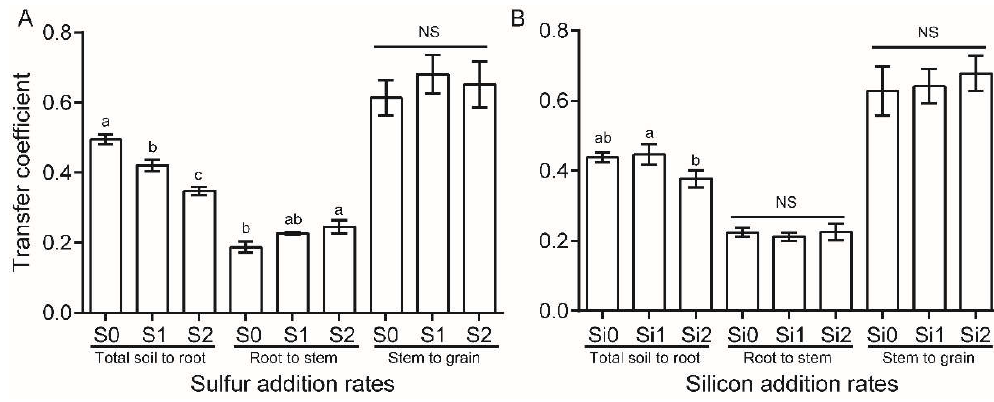
Figure 3. Transfer coefficient of Cu in the soil-root-stem-grain system in response to ( A ) sulfur and ( B ) silicon additions. Different letters on the bars indicate significant differences among sulfur or silicon additions. NS, not significant (Tukey HSD test, α = 0.05). Bars represent ± 1 standard error ( n = 9).